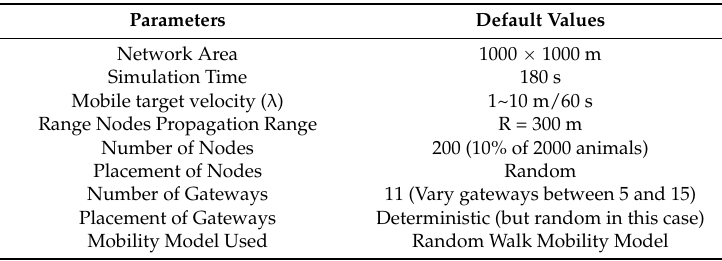
Table 1. Default simulation configurations.